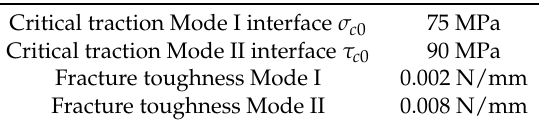
Table 2. Interface fracture properties.